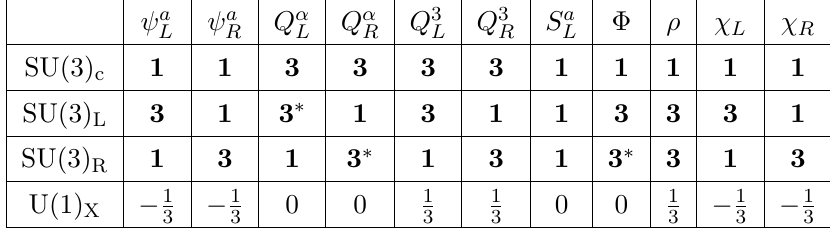
Table 1 . Particle content of the model, with a = 1 ; 2 ; 3 and (cid:11) = 1 ;